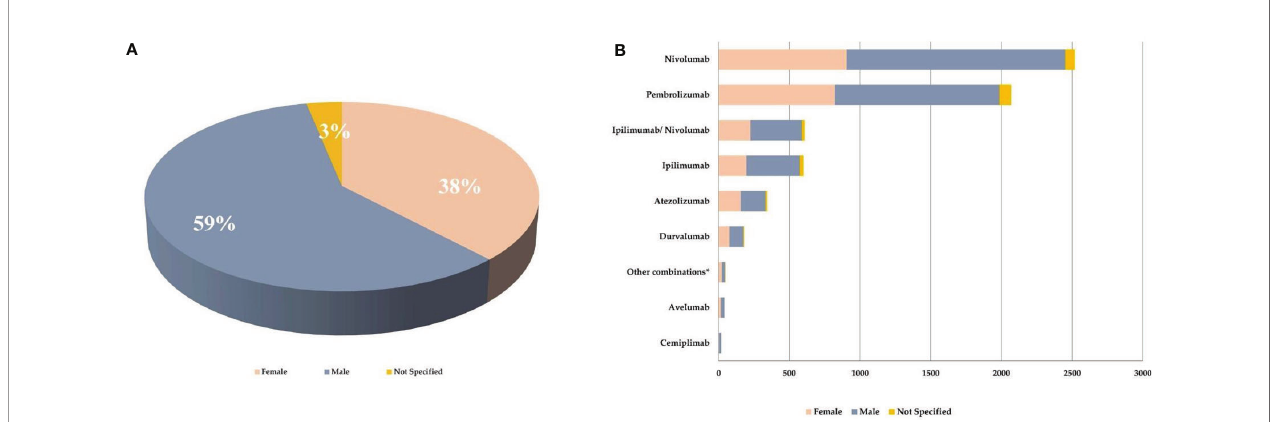
FIGURE 2 | (A) Gender distribution of neurological consequences occurring in European patients treated with at least one ICI and collected from the EudraVigilance database until February 7, 2020. (B) Gender distribution of neurological outcomes collected from EudraVigilance categorized by single ICI treatment. *pembrolizumab/nivolumab/ipilimumab, pembrolizumab/atezolizumab, ipilimumab/pembrolizumab.